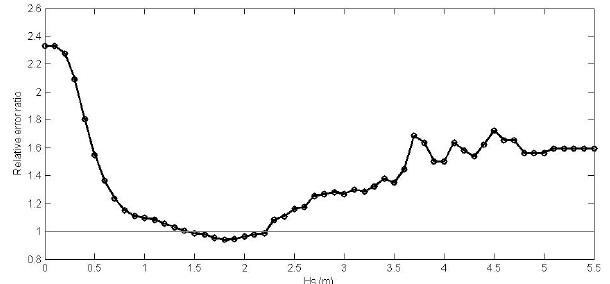
Fig. 3. Mean ratio between relative errors of calibrated and uncalibrated HIPOCAS data for subsets of time series of H s greater than the values of x-axis (for the time period 1991–2001 from Tortosa buoy: 40 ◦ 43.29 0 N, 00 ◦ 28.89 0